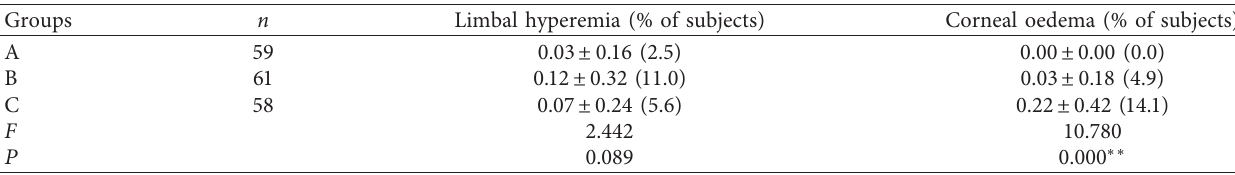
Table 4: Clinical sign scores at 24 hours after surgery in the 3 groups.